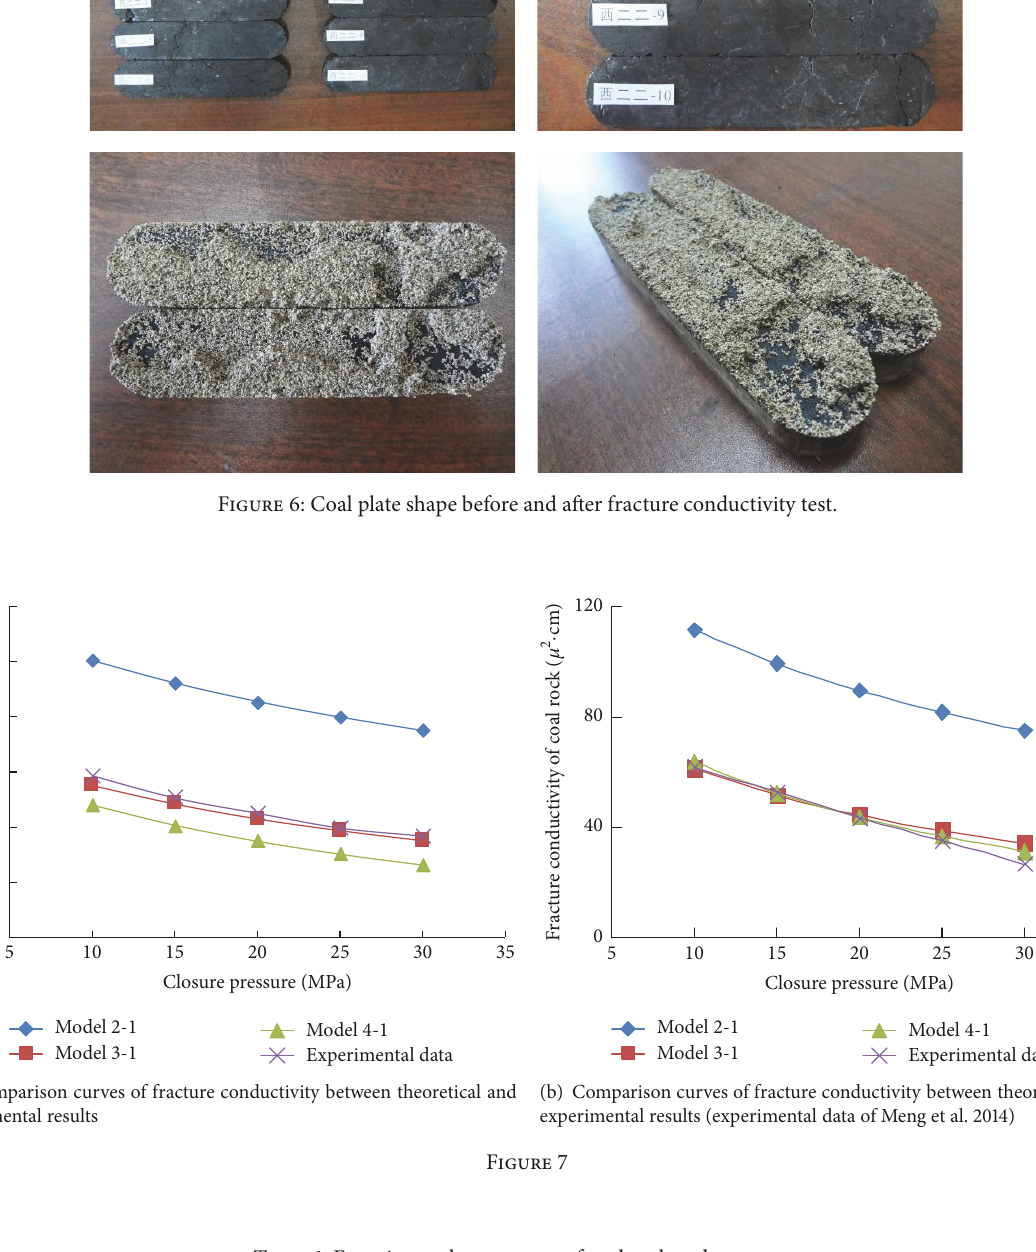
Table 1: Experimental parameters of coal rock and